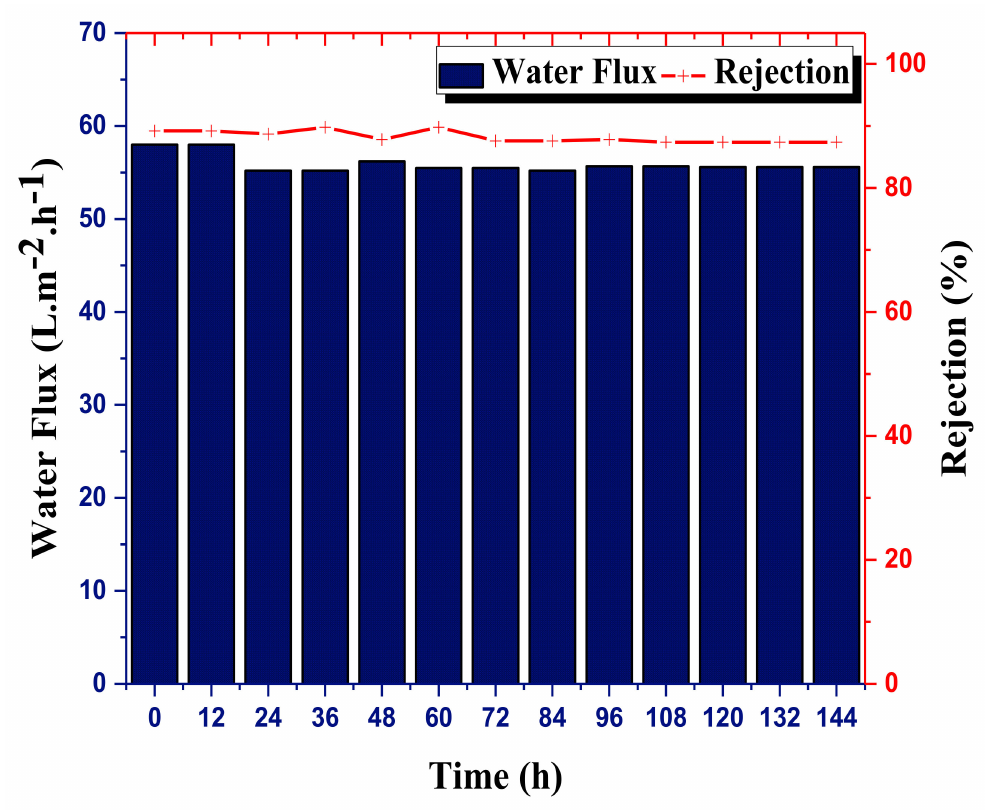
Figure 8. Long-term stability test on the novel fabricated membrane (NF_PAN_Ti). Test conditions: 0.6 MPa; cross − ] = 500 mg/L, 144-h flow rate = 30 L · h − 1 ; [MgCl 2